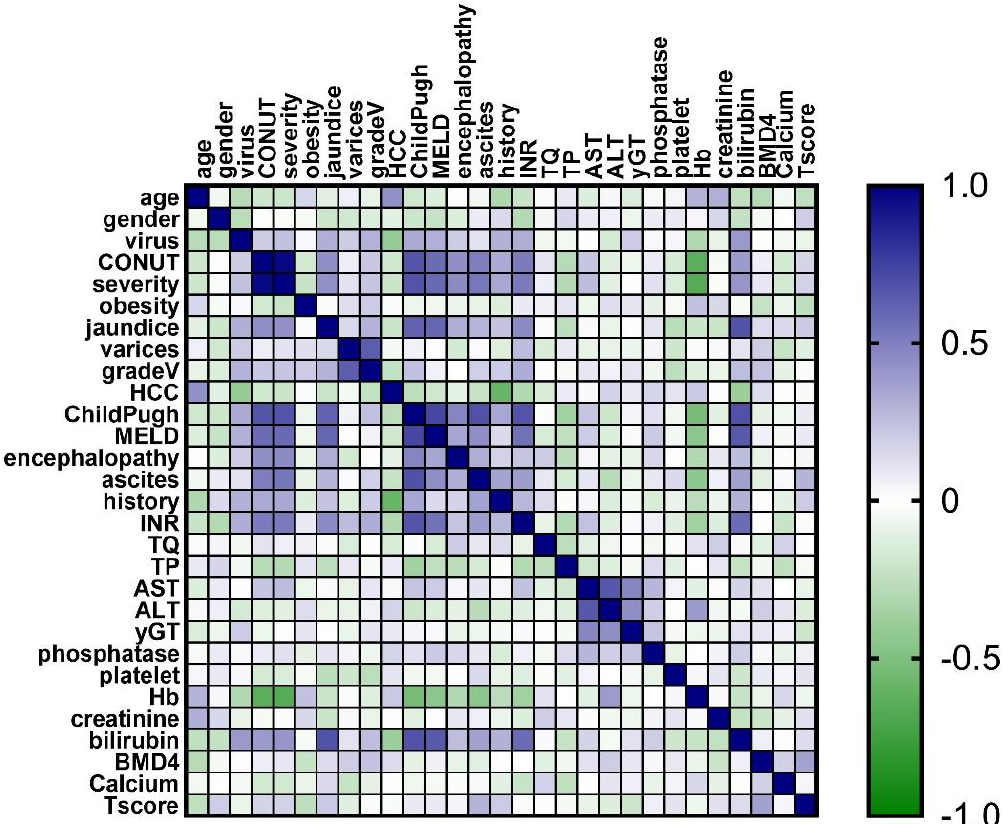
Figure 4. The correlation heatmap between measured indicators (colors range from bright blue for strong positive correlations to bright green for strong negative correlations). BMD, bone mineral